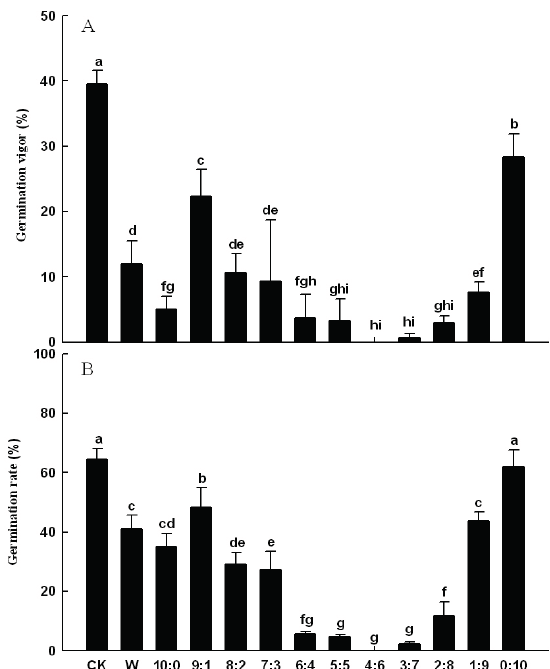
Figure 1. Effects of C. cathayensis exocarp extract and elution fractions on lettuce seed germination ( A ) germination vigor, ( B ) germination rate. Data are the mean ± SD values (n = 3). Final means with different letters are significantly different at p =